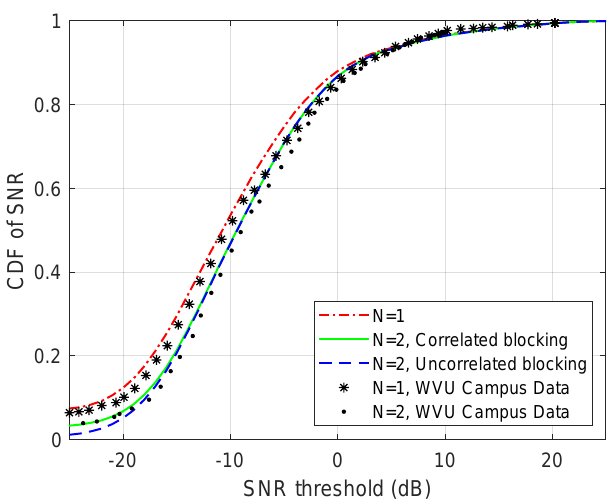
Figure 10. The distribution of SNR over 1000 network realizations when N = 1,2 using diversity combining, plotted using the real data model and the analytical